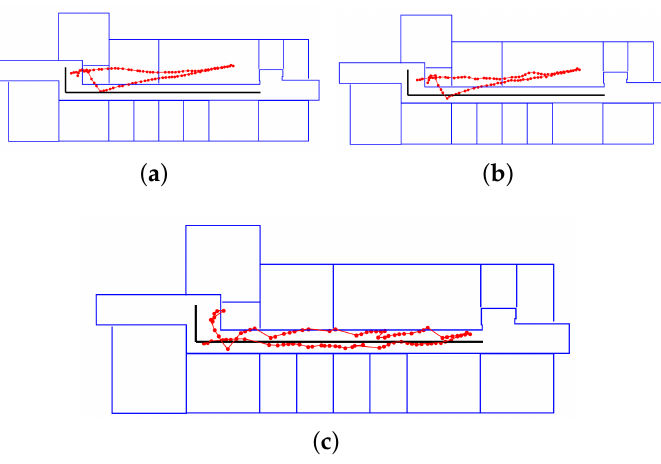
Figure 11. Trajectory of Route 1 with an inaccurate initial position, where red lines represent the trail of user and black lines indicate the ground truth: ( a ) PDR locations; ( b ) PDR locations after orientation filtering; and ( c ) the path derived from the fusion